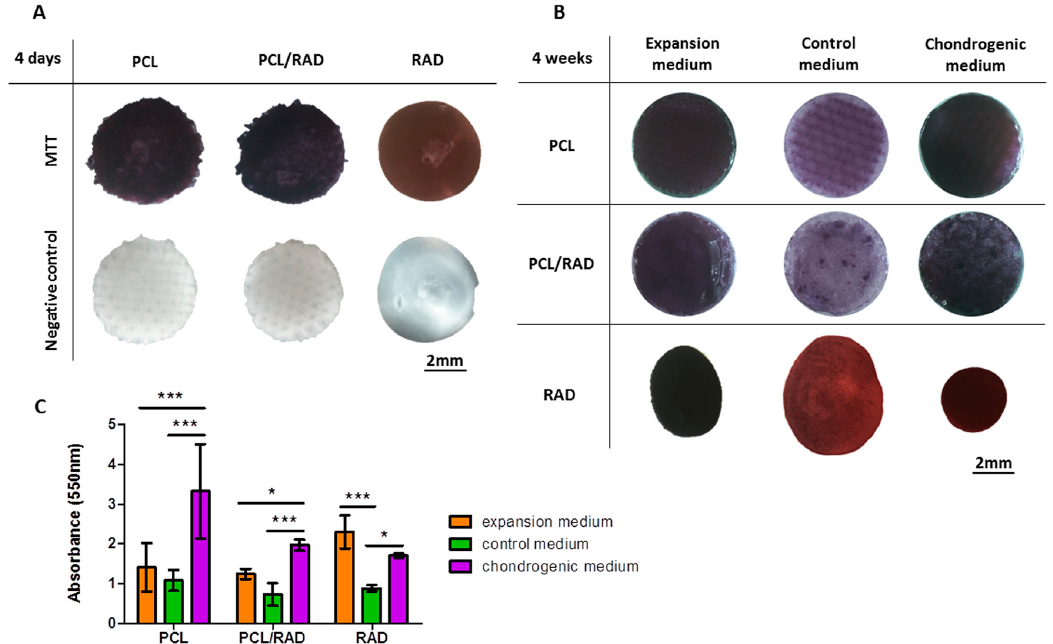
Figure 2. Viability of Articular Chondrocytes (AC) cultured in 3D scaffolds at different time points. PCL, PCL/RAD composite, and RAD scaffolds were seeded with AC and incubated with MTT to assess cell viability and distribution. ( A ) Construct appearance after MTT incubation at 4 days of culture with expansion medium. The same constructs were incubated in the absence of MTT reagent as a negative control; ( B ) Construct appearance after MTT incubation at 4 weeks of culture with the different culture media: expansion, control and chondrogenic media; ( C ) MTT values at 4 weeks of culture were expressed of formazan (product) absorbance at 550 nm. (Statistical differences are indicated as: * for p < 0.05, ** for p < 0.01, and *** for p < 0.001, Two-way ANOVA, N = 2 n = 3).